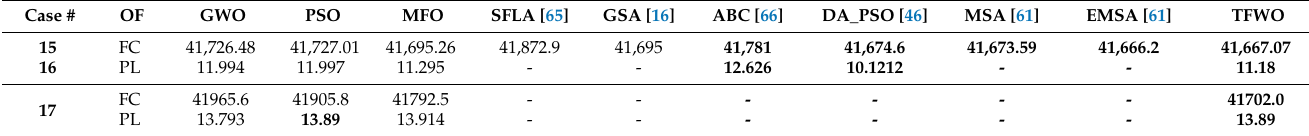
Table 9. TFWO versus recent optimization algorithms for IEEE-57 bus test system: Cases 15–17.